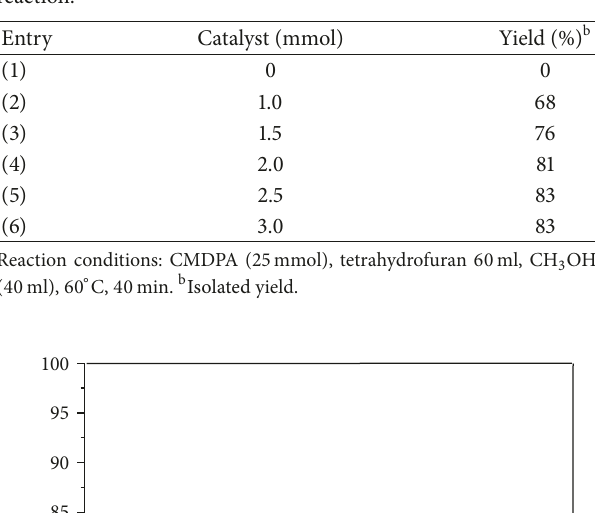
Table 3: Effect of the amount of ionic liquid [bmim]OH on the reaction.